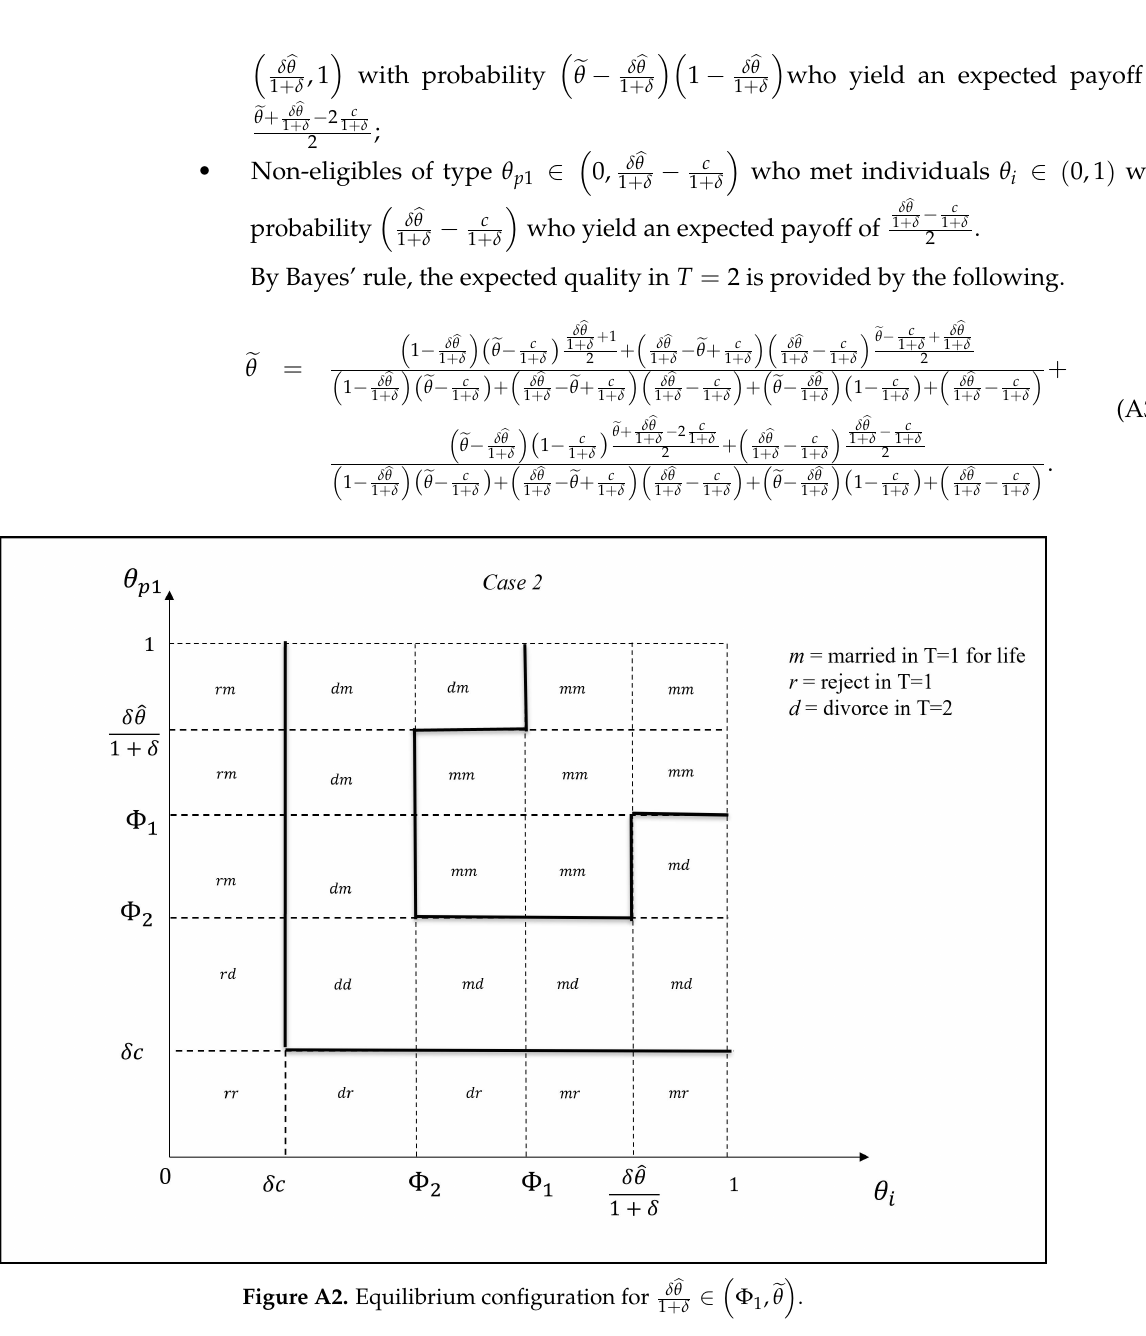
(cid:16) (cid:17) Φ ∈ 1 , (cid:101) θ 1 + δ